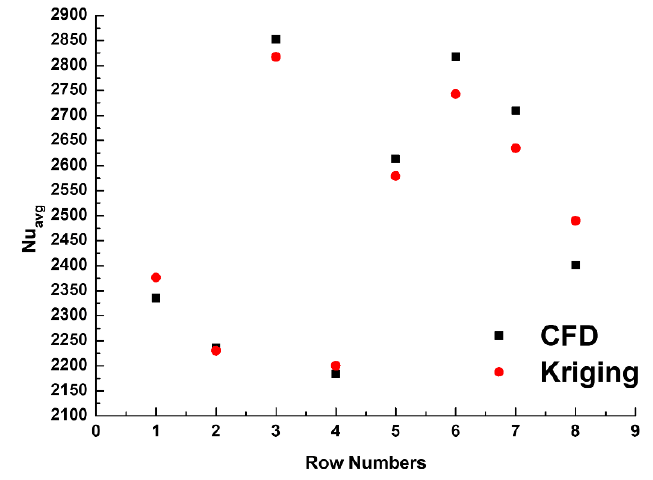
Figure 20. Results obtained from the Kriging and CFD models.